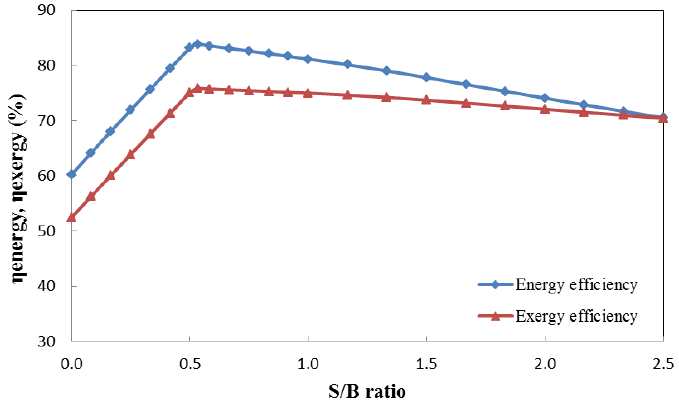
Figure 5. Energy and exergy efficiencies of the HTAG process as a function of S/B ratio for T = 1000